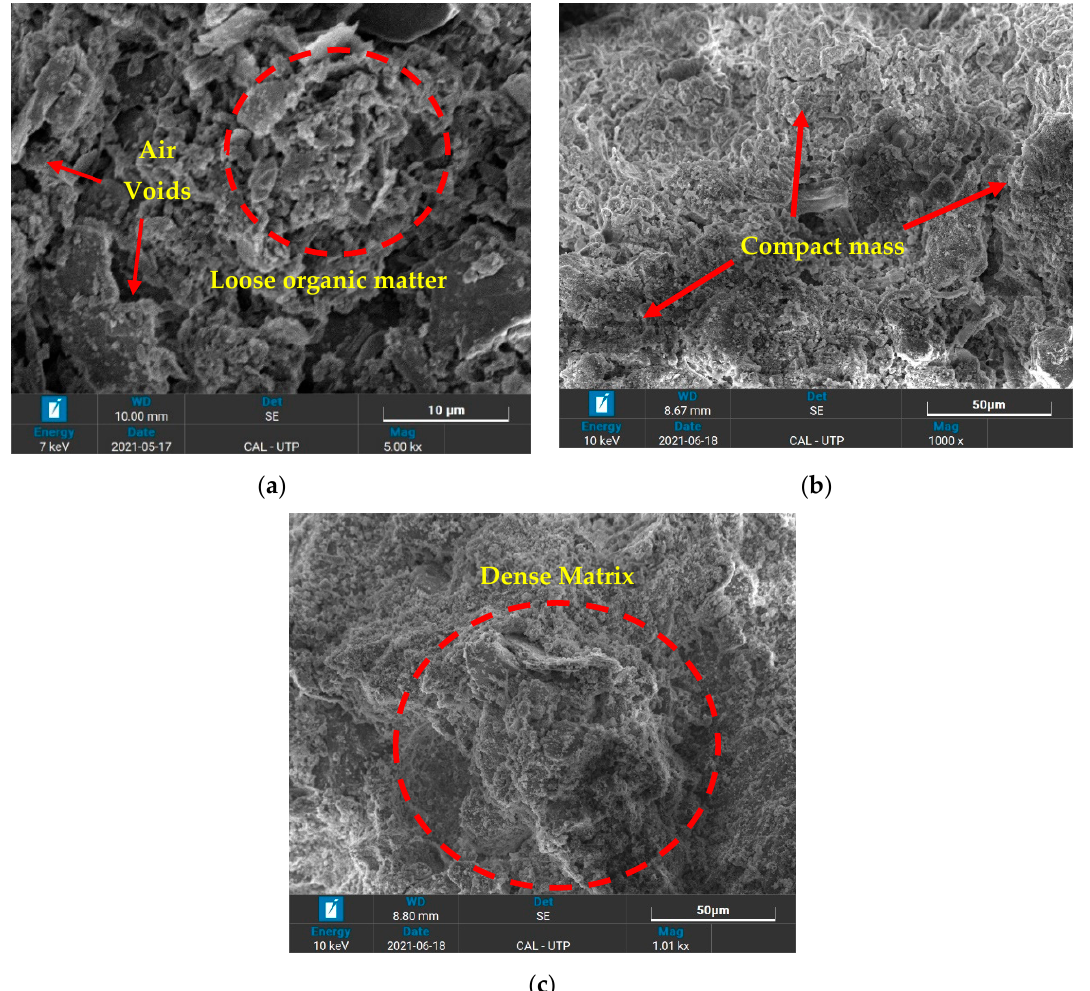
Figure 12. Micrographs of treated and untreated peat: ( a ) peat; ( b ) peat and SF; and ( c ) peat, SF, and OPC.